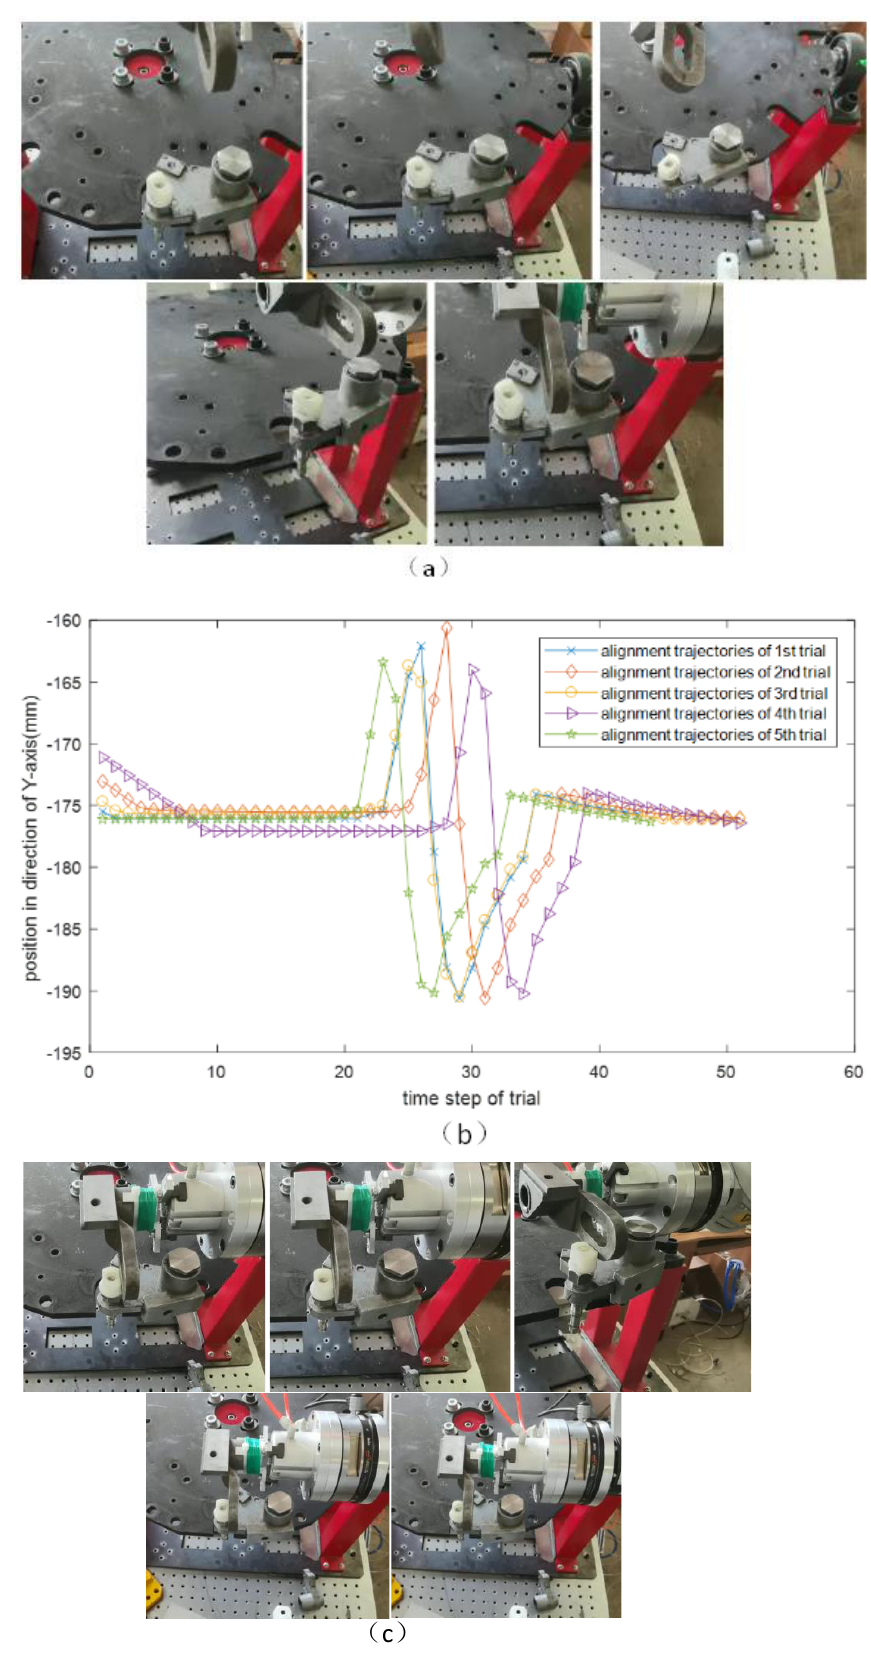
Figure 17. The reliability and repeatability validation from 5 experiments. ( a ) snapshot of the initial position and posture; ( b ) the position in direction of Y -axis in the error compensation stage; ( c ) snapshot of the final state of the error compensation stage.